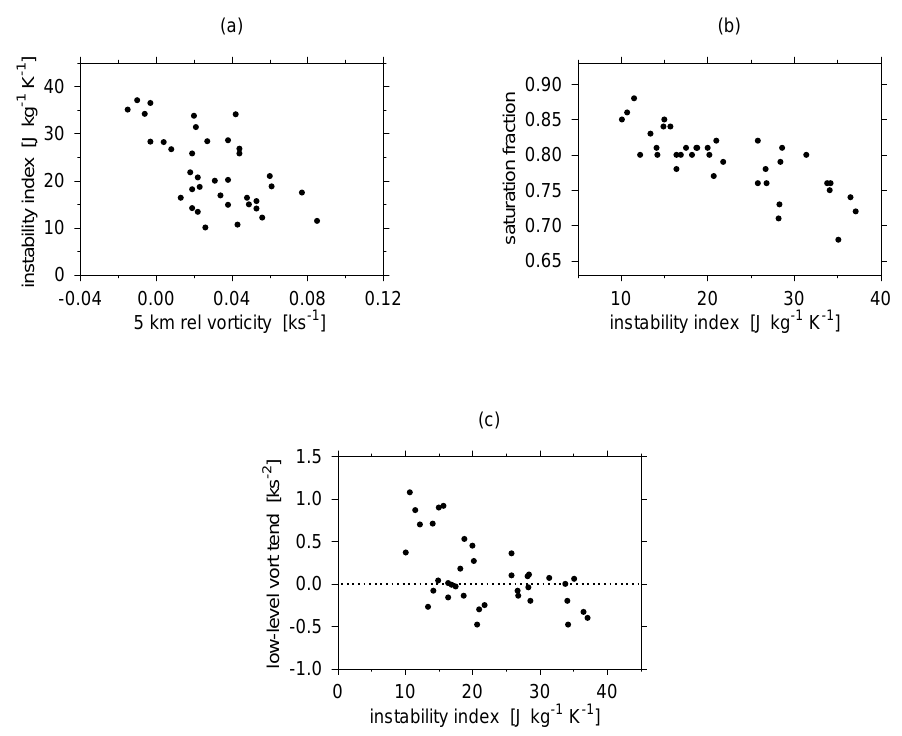
Fig. 1. Scatter plots of (a) mid-level relative vorticity versus instability index, (b) instability index versus saturation fraction, and (c) instability index versus low-level vorticity tendency. Table 2. Statistics on the scatter plots in Fig. 1.